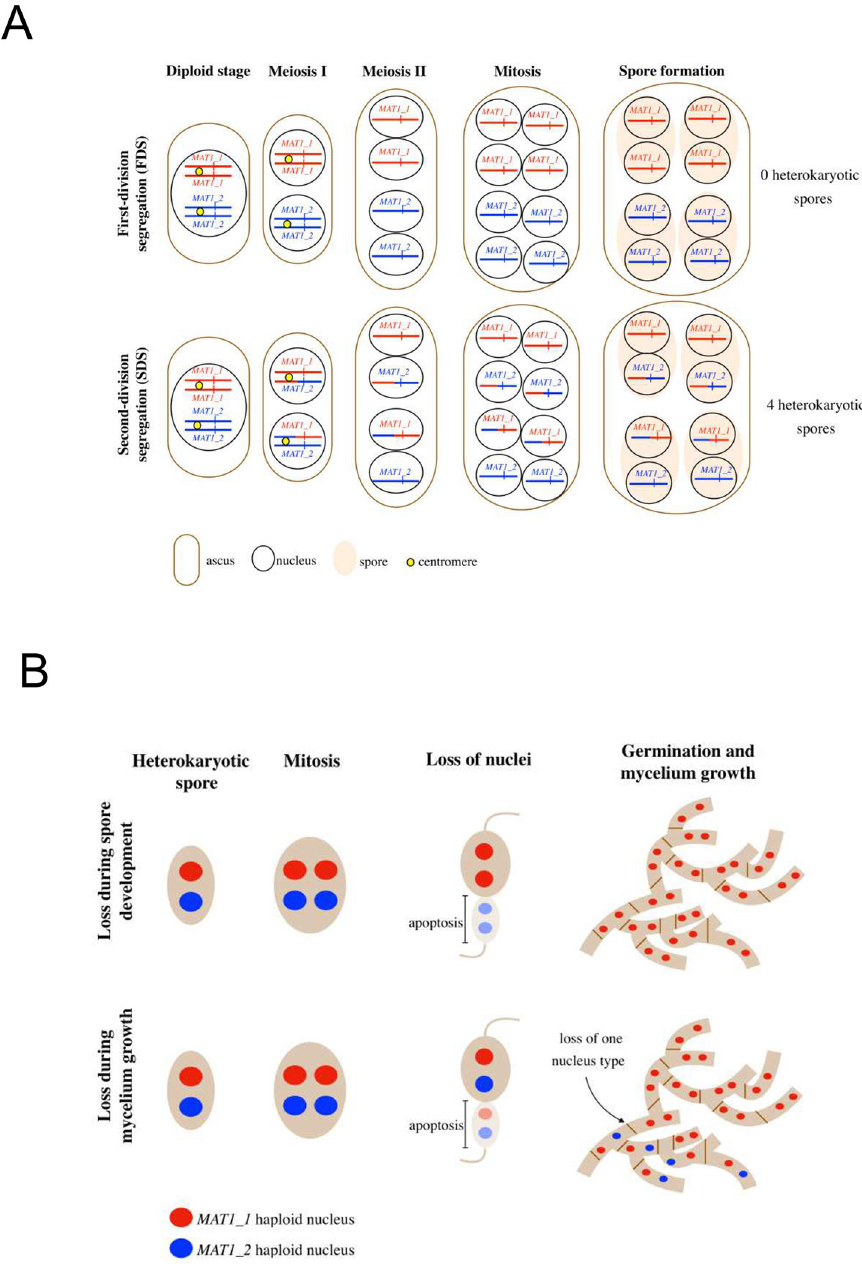
Fig 3. Tested scenarios of segregation of the mating-type locus during meiosis and theoretical ascus composition and hypothetical scenarios for the loss of one mating type in thalli of Schizothecium tetrasporum . A. Theoretical composition of an ascus according to meiotic segregation pattern at the mating-type locus: if alleles at the mating-type locus (represented as a red or blue vertical bar) segregate during the first meiotic division (FDS, top), two MAT-1-1 spores and two MAT-1-2 spores are formed; conversely, if alleles at the mating-type locus segregate during the second meiotic division (SDS, bottom), four heterokaryotic spores carrying both mating types are formed. Only the chromosomes carrying the mating-type locus are represented, with their centromeres. The MAT-1-1 and MAT1-2 alleles at the mating-type locus are represented by red and blue vertical bars, respectively. Centromeres are represented by yellow circles at the diploid and meiosis I stages. Chromosomal arms are colored in red or blue according to the parental origin of the chromosomal fragment. B. Two hypothetical scenarios for the loss of one mating type despite SDS at the mating-type locus. SDS at the mating-type locus generates a spore carrying two nuclei of opposite mating types, but one nucleus may be lost during spore development (top) when half the nuclei gather in a region of the spore that subsequently undergoes degeneration, or during mycelium growth